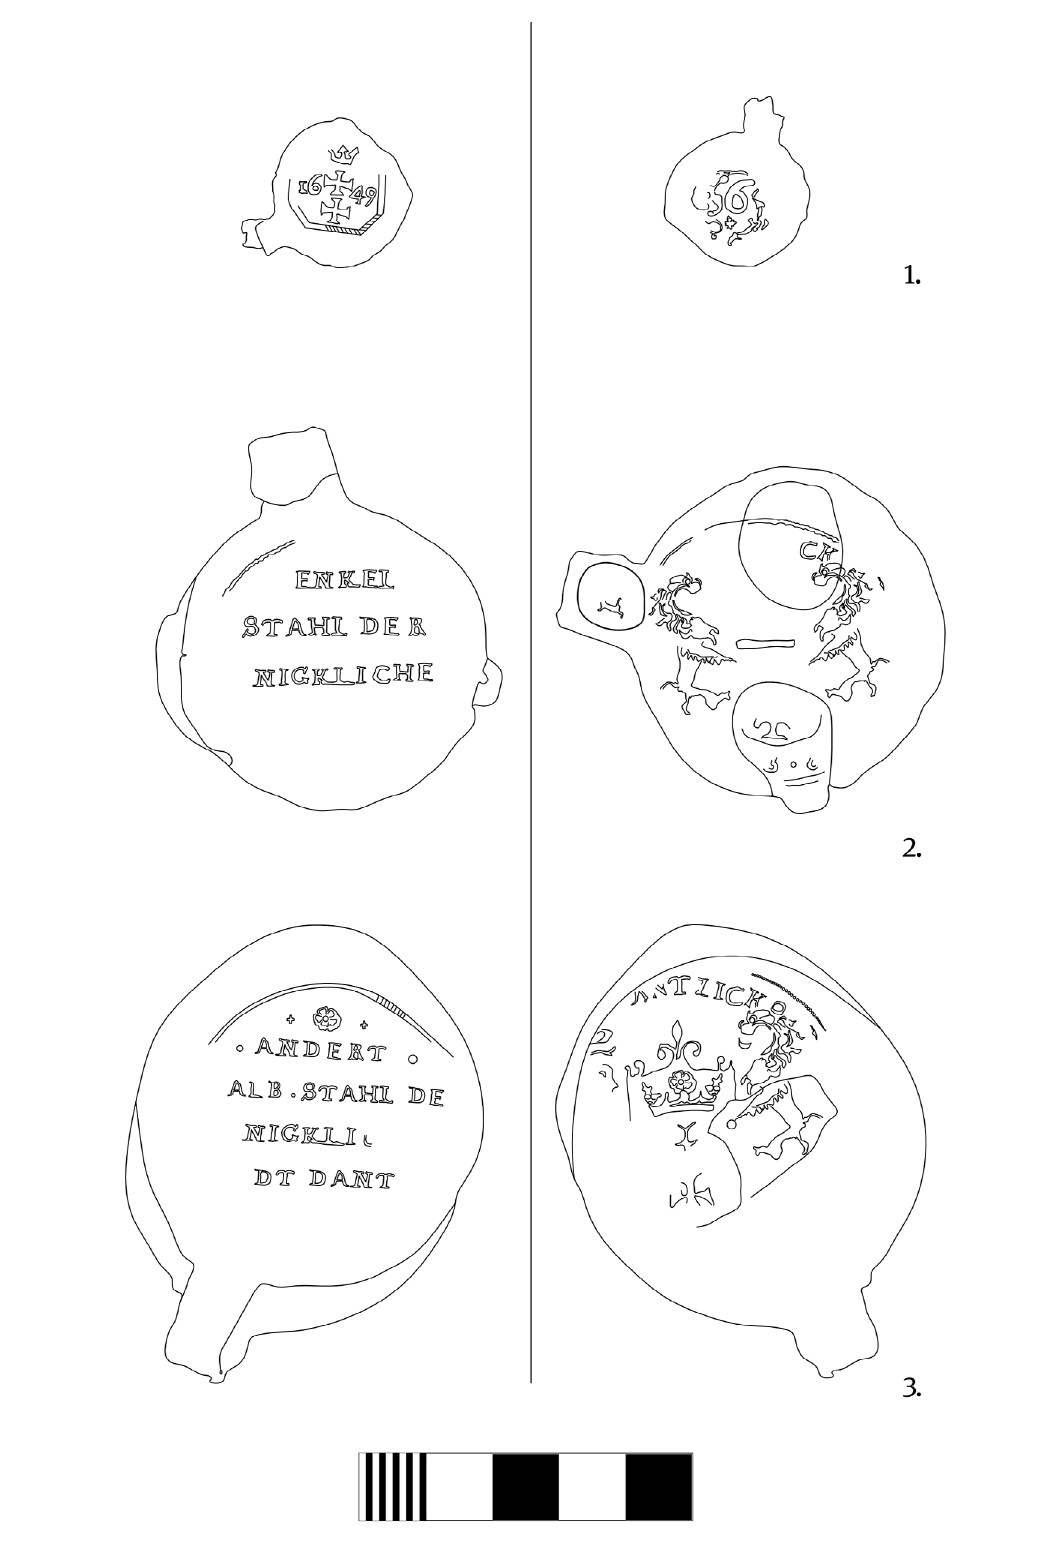
Figure 28. Lead seals originated from Gdańsk